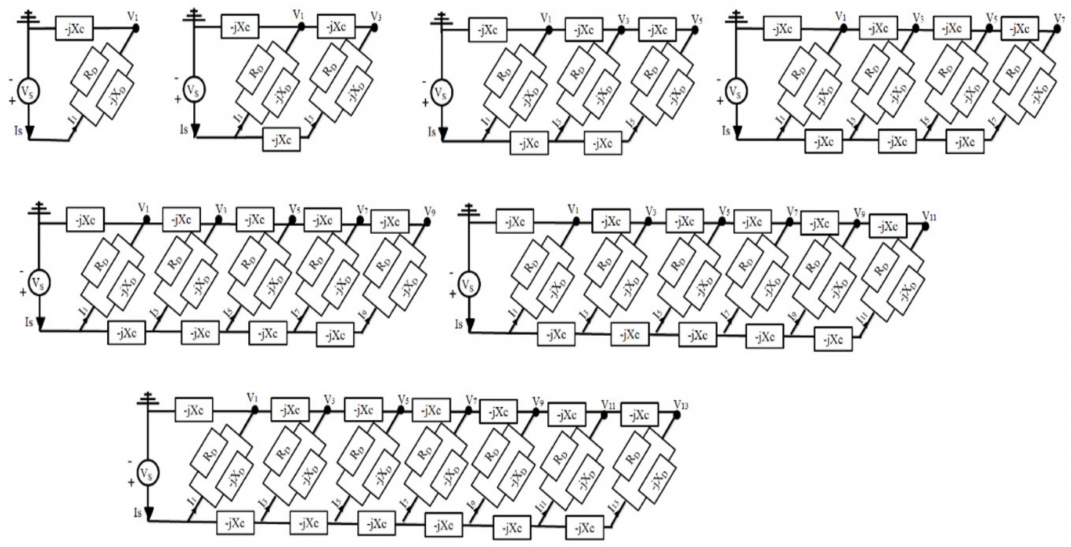
Figure 9. The linearized design of Cockcroft–Walton during negative peak.